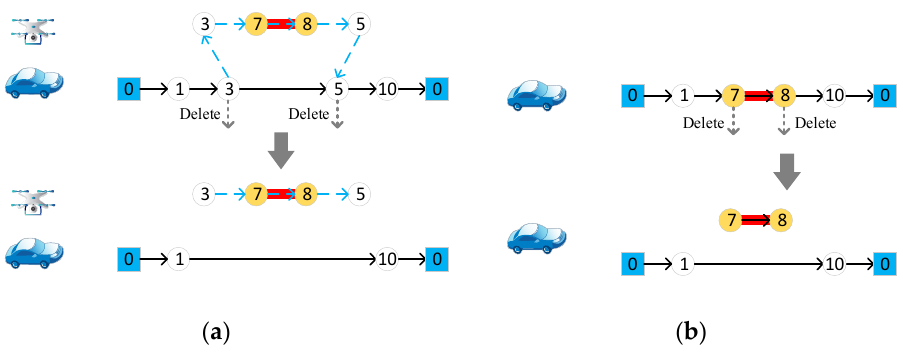
Figure 7. Delete target edge. ( a ) Delete target edge accessed to drones; ( b ) delete target edge accessed to vehicle. Different numbers in the figure represent different nodes of the road network.